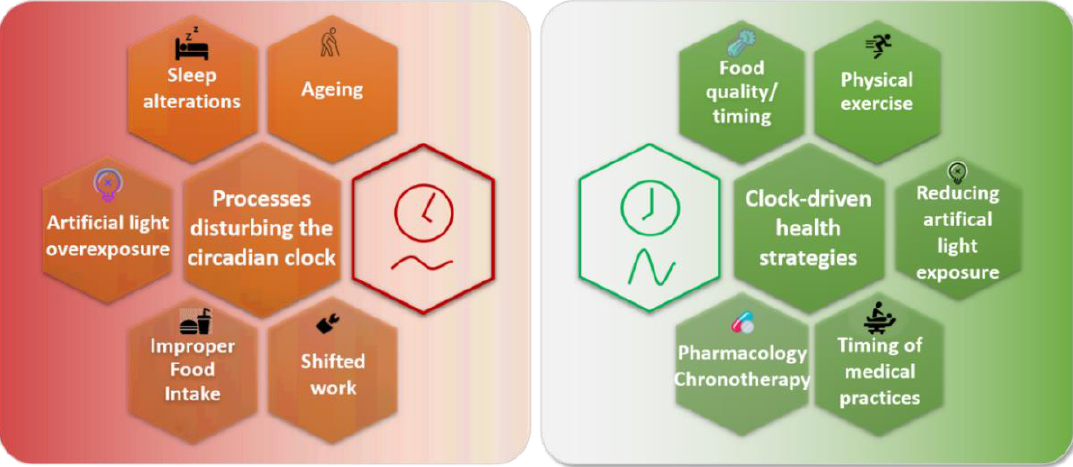
Figure 3. Restoring a proper alignment between the human circadian clock, metabolism, and